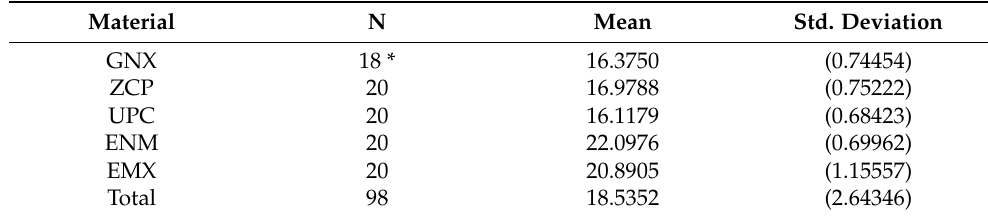
Table 7. Descriptive TP values for the aged groups. * Outliers were